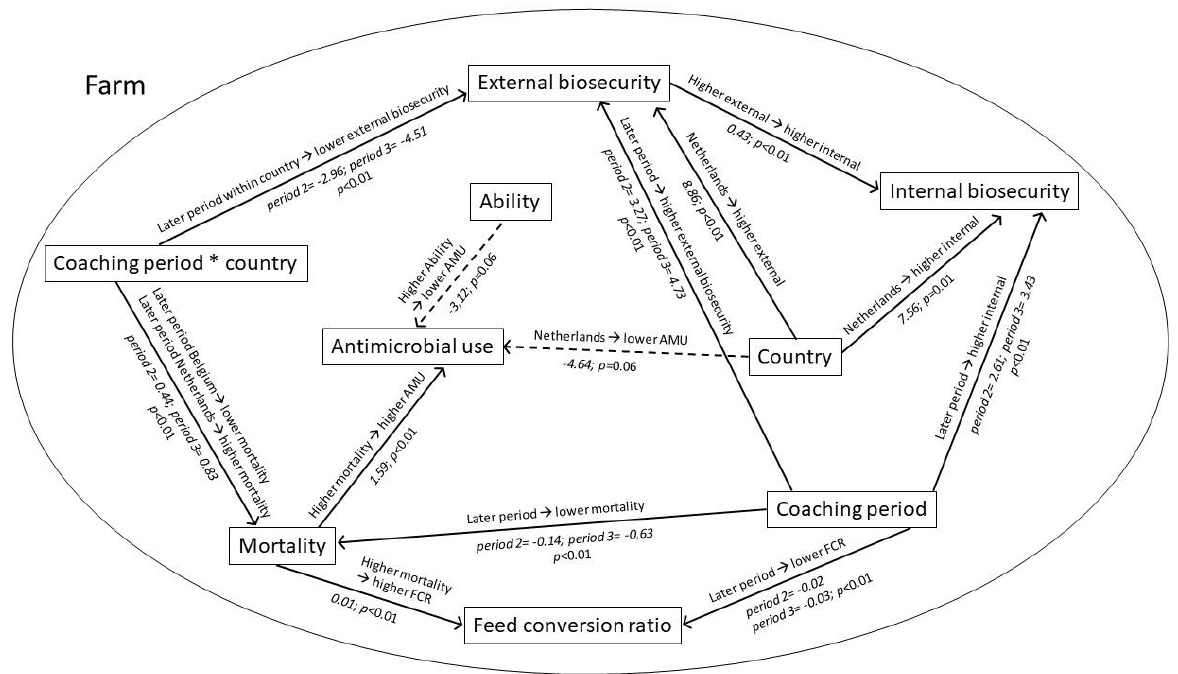
Figure 3. Association pathway according to a linear mixed model. The model included country, coaching period, biosecurity levels, performance parameters (mortality, feed conversion ratio), ADKAR ® elements, and antimicrobial use. AMU: antimicrobial use; FCR: feed conversion ratio. Coaching period * country: the interaction between coaching period and country. The model was corrected for farm effects by assigning the latter as a random factor. Estimates were added to the pathway in italics. The non-significant associations with AMU are indicated with a dashed arrow. we looked at whether they had an AMU below, equal to, or above the country-specific median value within the different coaching periods. Table 3. The number of farms per country and coaching period are grouped according to their score (low/high) for each ADKAR ® element and their antimicrobial use below or equal to/above the country-specific median value.